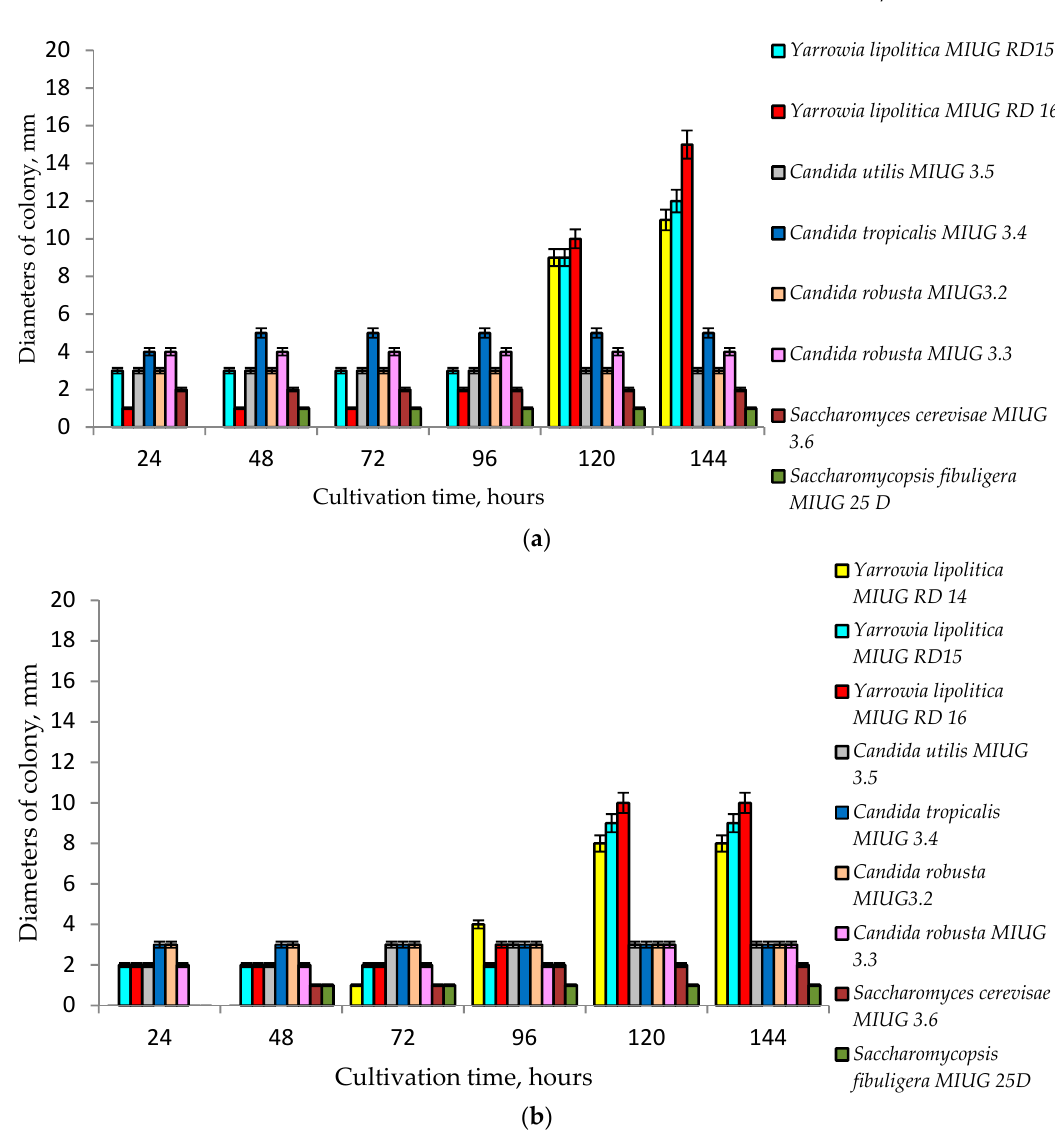
Figure 3. ( a ) Impact of 0.2% reactants on the growth of different strains of yeast; ( b ) impact of 0.3% reactants on the growth of different strains of yeast.